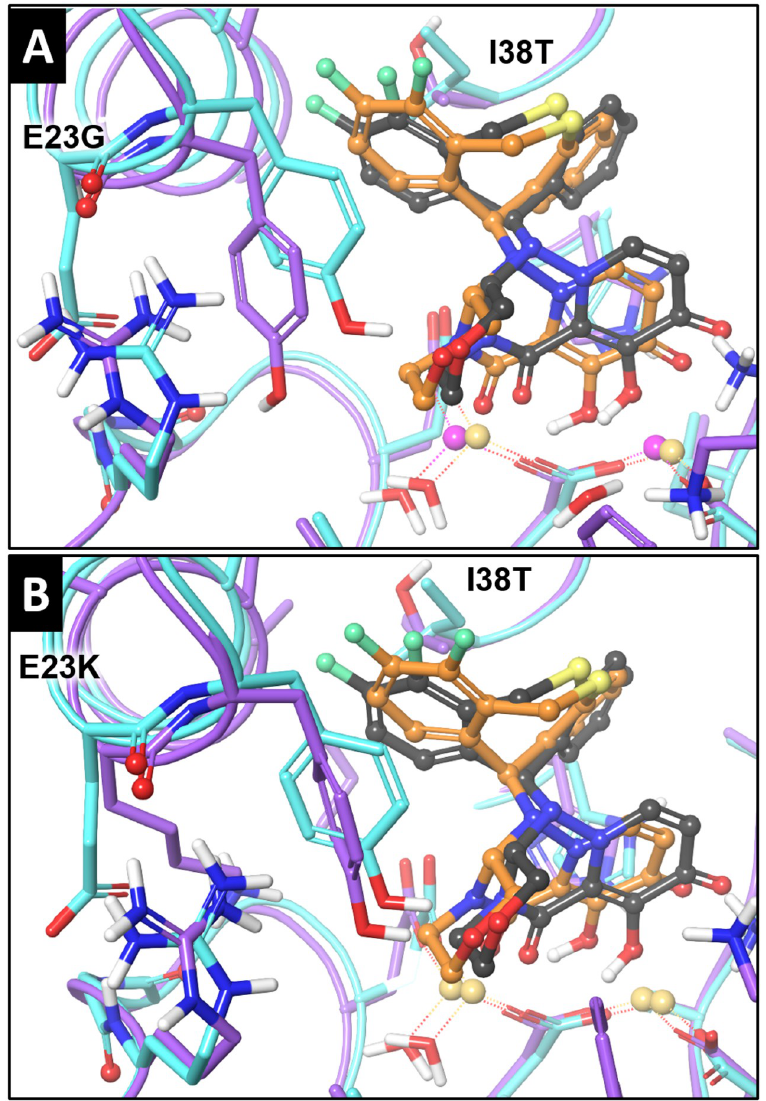
Fig 8. Modeling of the BXA-rPA N binding interface of A(H1N1)pdm09 with E23G/K+I38T. A) The aligned binding interfaces of BXA in WT and E23G+I38T PA N . B) The aligned binding interfaces of BXA in WT and E23K +I38T PA N . Light blue tubes: WT PA N ; violet tubes: E23G/K+I38T-substituted PA N ; black balls and sticks: the BXA pose in WT PA N ; orange balls and sticks: the BXA pose in E23G/K-substituted PA N